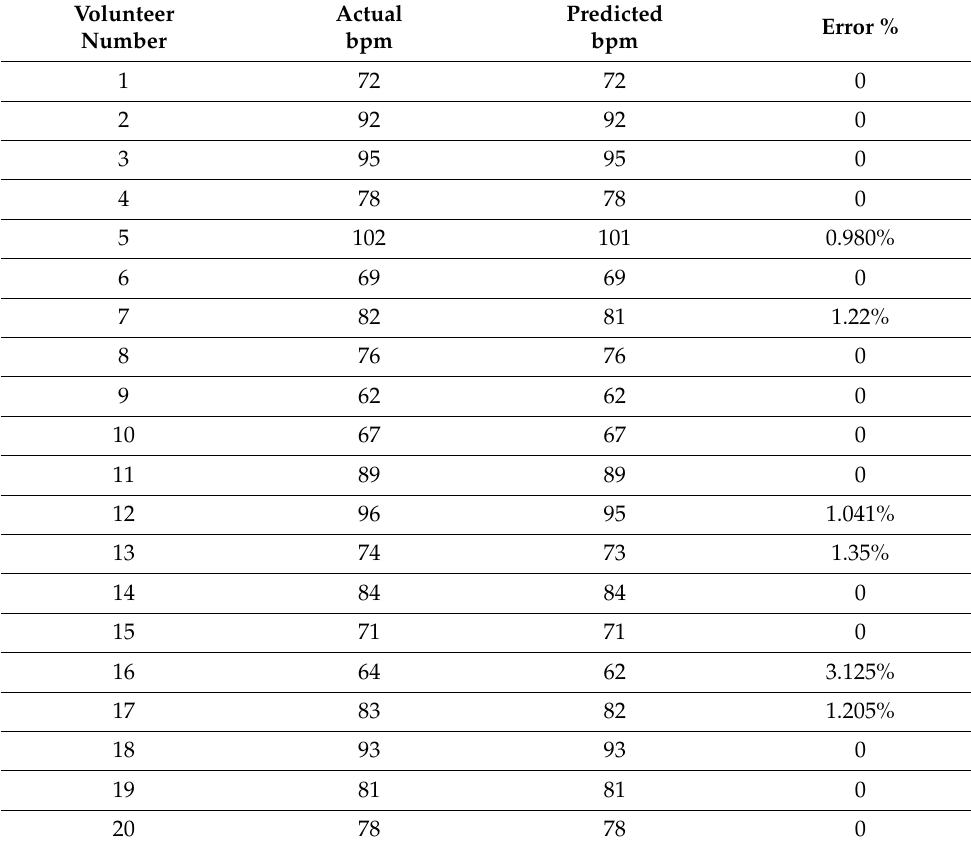
Figure 4. MAE and MSE evaluation using the integration of AlexNet and ResNet50V2. Table 3 lists the actual heartbeat, predicted heart rate, and error percentage between actual and estimated heart rates. This table indicates that the maximum obtained error among all volunteers is 3.125%. In addition, this table shows that the proposed technique correctly predicted 70% of the sample size. Moreover, the obtained MAE was 0.3, and MSE was 1.8. Both values are small, implying that the presented model estimated heart rate with an acceptable level of correctness. To obtain the actual heartbeat rates for all